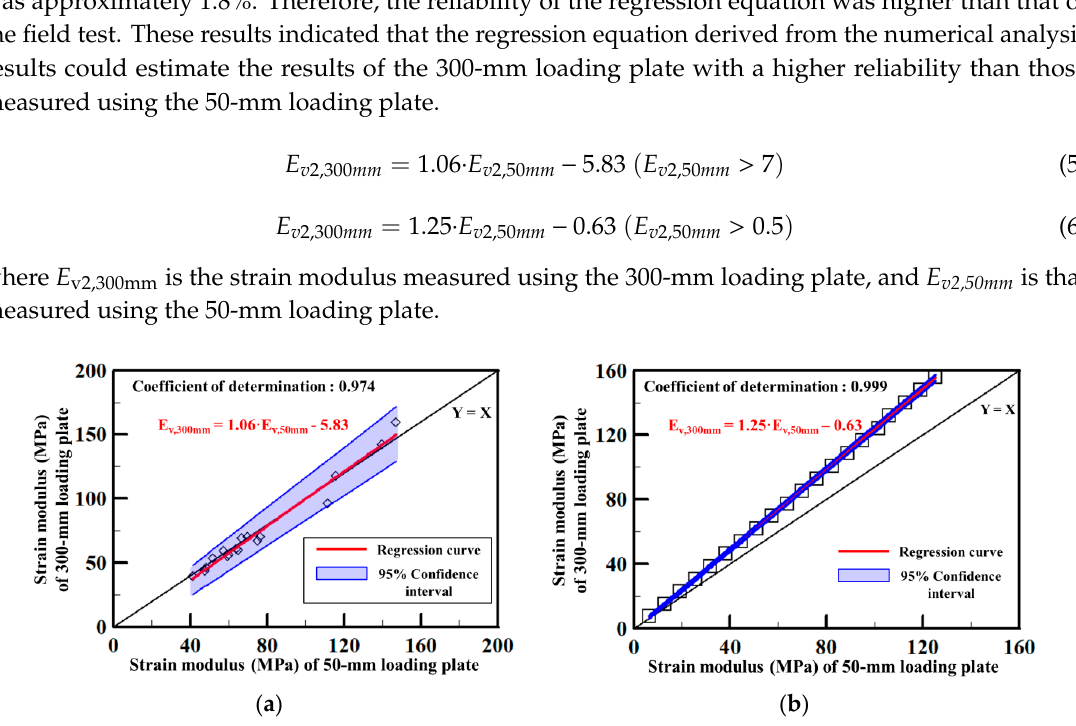
Figure 4. Regression analysis comparison between the field-test and numerical analysis results: ( a ) field-test results (Jung et al. [6]); ( b ) numerical analysis results. 4.2. Loading-Plate Scale E ff ect of the Repetitive Plate-Loading Test under Field-Test Roadbed